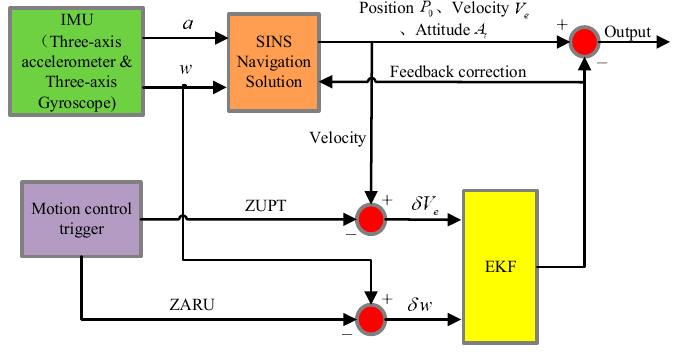
Figure 9. Flow diagram of the correction solution.